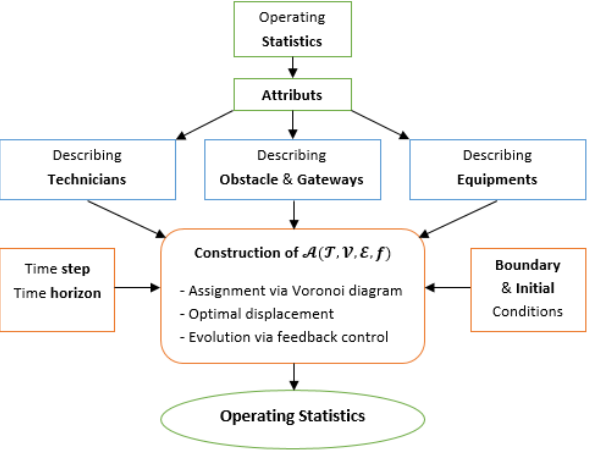
Figure 1. Principle of maintenance process control by